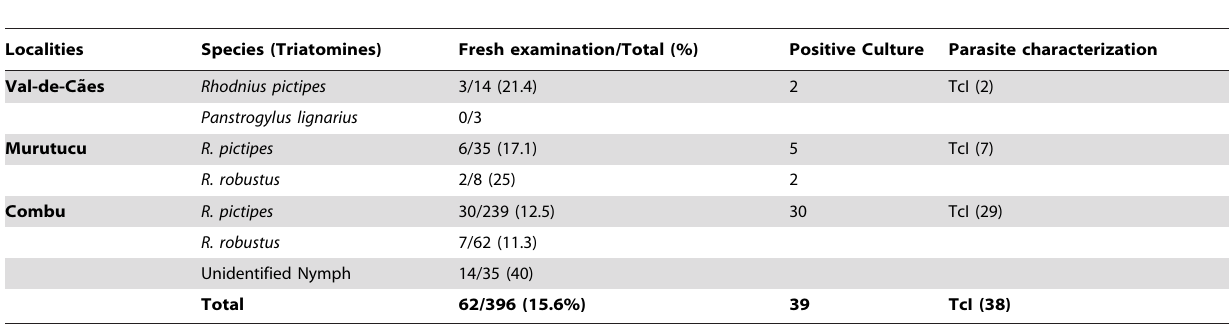
Table 3. Prevalence of Trypanosoma cruzi infection in triatomines examined in Val-de-Ca˜es, and islands Combu and Murutucu, Bele´m